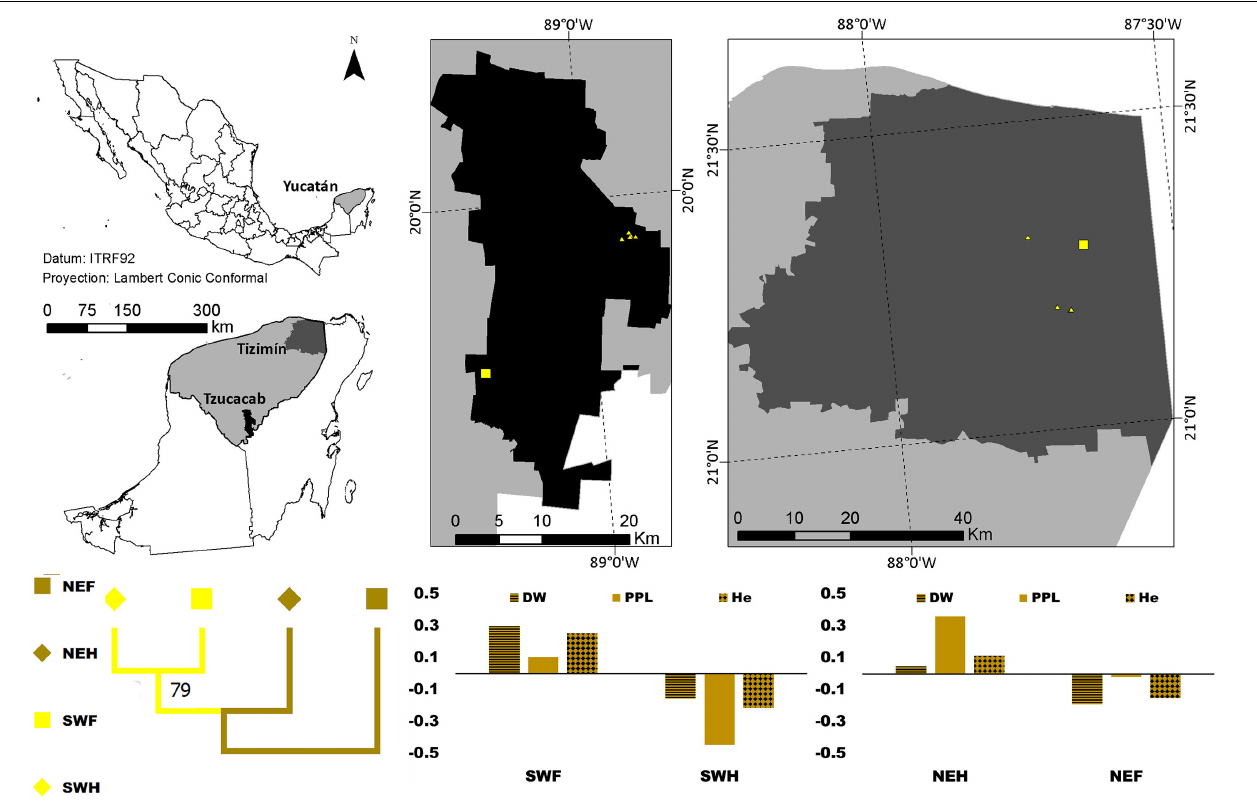
FIGURE 3 | Distribution of forest (square) and homegarden (triangle) individuals of Spondias purpurea in two regions of Yucatán, México. The graphic depicted the standardized mean values for PPL- horizontal lines, DW -solid color, and He-diamond pattern (cid:0) x i − x (cid:1) / x where x i is the mean value per region/population type and x the overall mean value]; negative and positive values indicate values below and above the overall mean. The dendrogram for the paired F ST between each combination of the region (northeast -NE- dark yellow, and southwest-SW- light yellow) and population type (forests -squares- and homegardens -diamonds-) suggests almost no differentiation between southwestern forest and homegarden populations with a 79% bootstrap support, and this group and the homegarden of northeastern